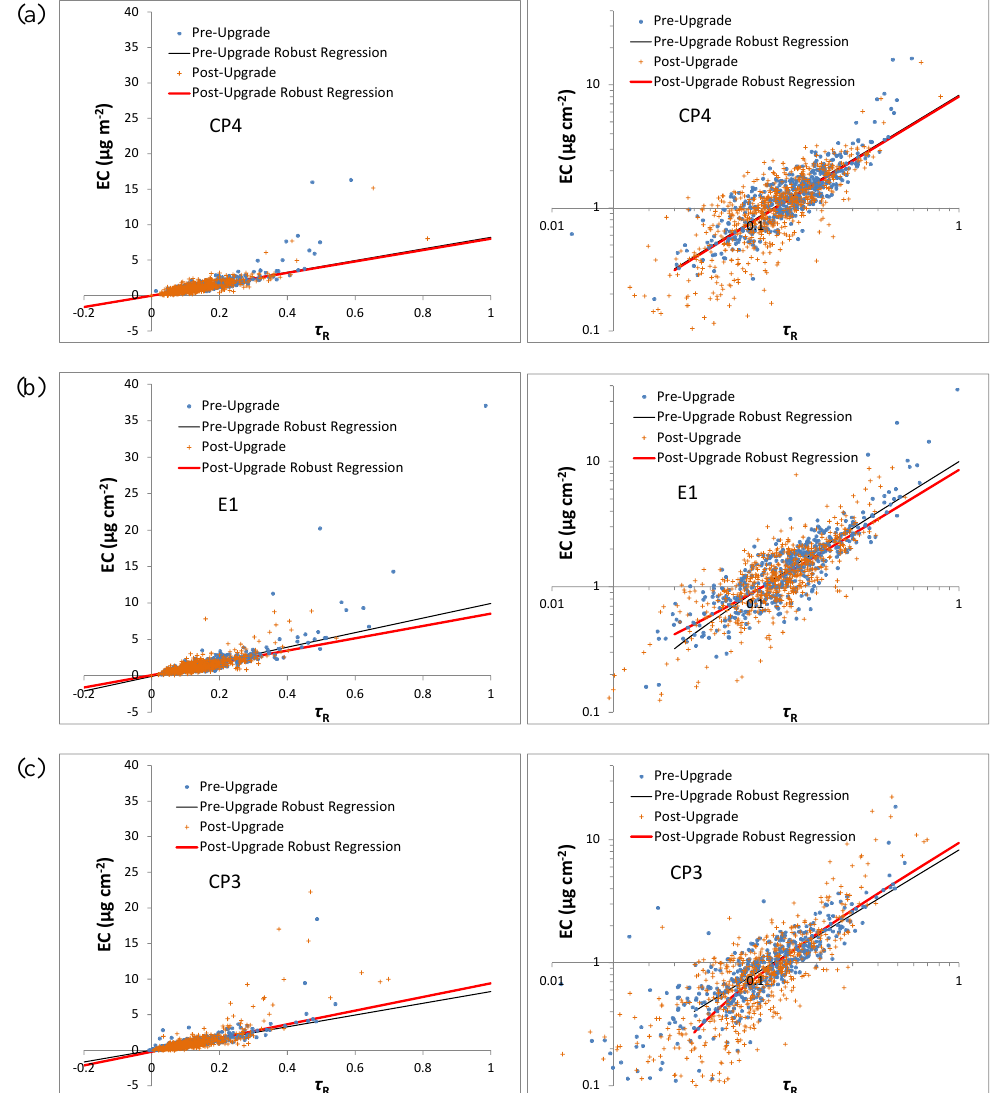
Fig. 5. EC- τ R scatter for: (a) Wemianche Wilderness (CP4), (b) Brigantine NWR (E1), and (c) Hance Camp at Grand Canyon NP (CP3) as an example of Group I, II, and III sites, respectively. Pre- and post-instrument upgrade periods (i.e., 2000–2004 and 2005–2009, respectively) are separated for robust regression analysis. Left panels: linear scale; right panels: log